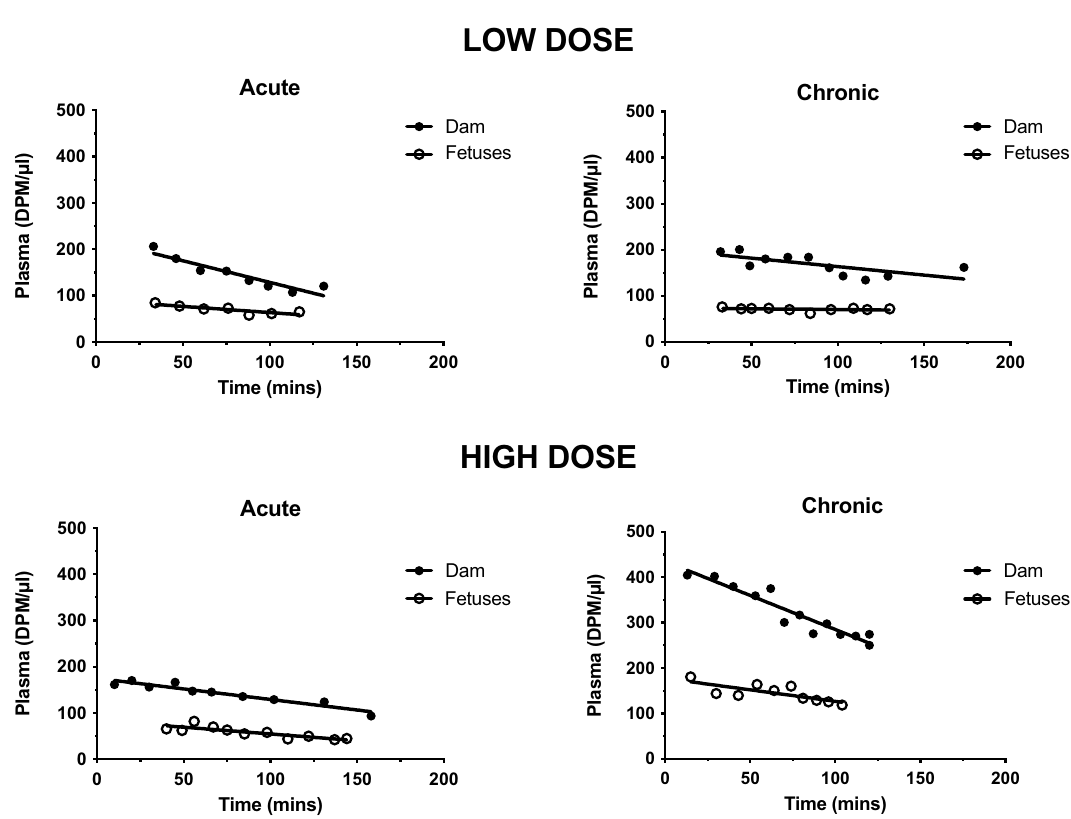
Figure 3. Activity levels (DPM/μl) of 3 H-paracetamol (acute and chronic experiments) in E19 fetal plasma. Above: low dose, 3.75 mg/kg. Below: high dose, 15 mg/kg. The maternal plasma levels for both acute and chronic experiments declined progressively throughout the experimental period. The fetal plasma levels also declined during this period, except in chronic low dose experiments. The levels in maternal and fetal plasma were higher with chronic high dose treatment. The lower levels for each drug in fetal plasma indicates a substantial restriction of drug transfer across the placenta. Fetal plasma, open circles. Maternal plasma, filled squares. Lines fitted by Least Squares Linear Regression, curve fitted by Least Squares Exponential Decay (one phase). Data for high dose experiments from Ref. 2